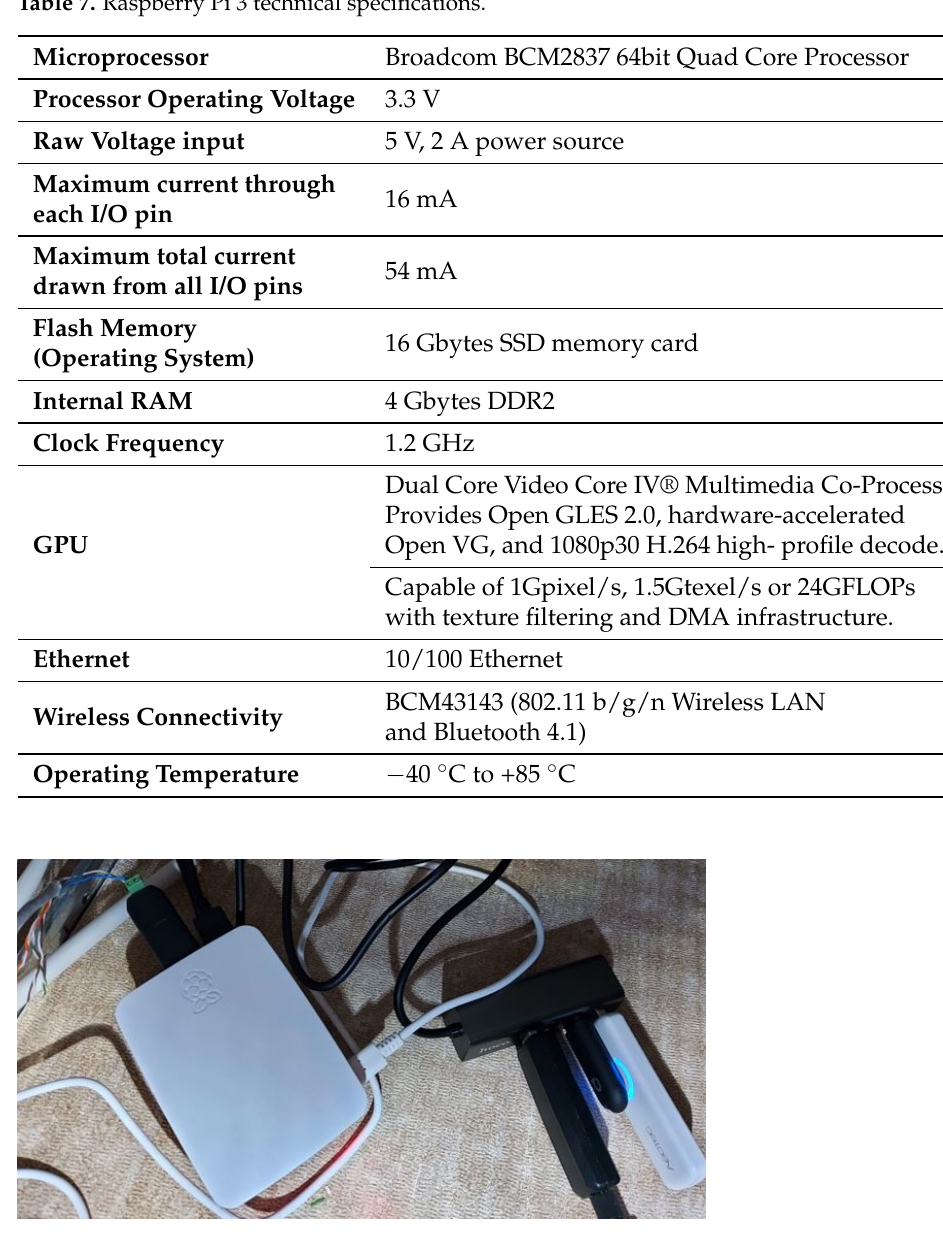
Figure 13. Edge: Raspberry Pi with dongle sticks. Table 8. Sensors and devices